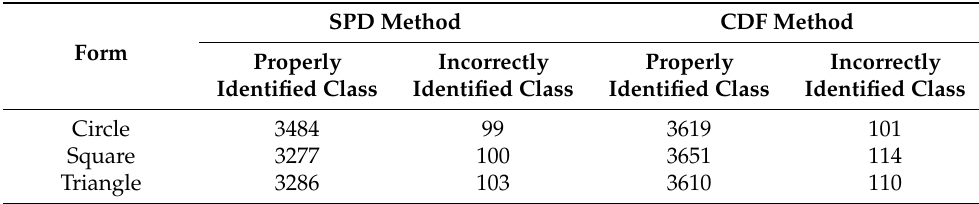
Table 4. Results of the classification of the main form data set.